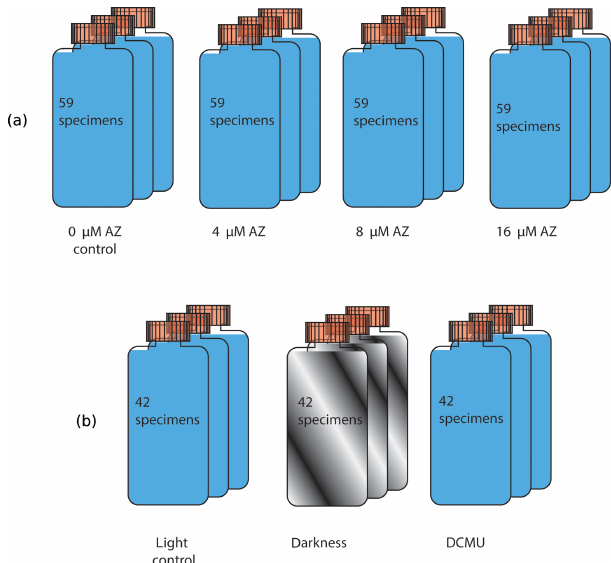
Figure 1. A total of 59 specimens were placed in one culture vial, with three replicate vials for each concentration of acetazolamide (upper row). Similarly, 42 specimens were incubated under light, in the dark and with the inhibitor DCMU (lower